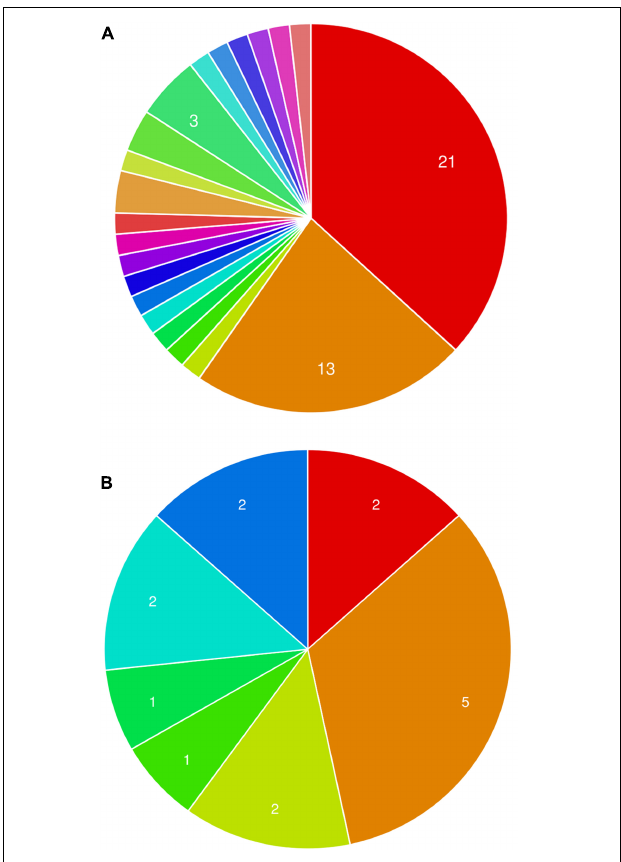
FIGURE 7 | Molecular function ontology of enzymes analyzed by signal P found in LC-ESI-MS/MS of M. phaseolina secretome. The enzymes other than the cell wall–degrading enzymes and proteases found in LC-ESI-MS/MS were first categorized based on the presence of the secretory signal peptide by signal P online tool. GO enrichment analysis was done using the UniProt IDs of the enzymes. (A) Molecular function of the genes corresponding to the enzymes that contain a signal sequence found in the LC-ESI-MS/MS. Almost 37.5% of the genes corresponding to the enzymes are involved in hydrolase activity. All the molecular functions found are as follows: catalytic activity, oxidoreductase activity, inorganic diphosphatase activity,